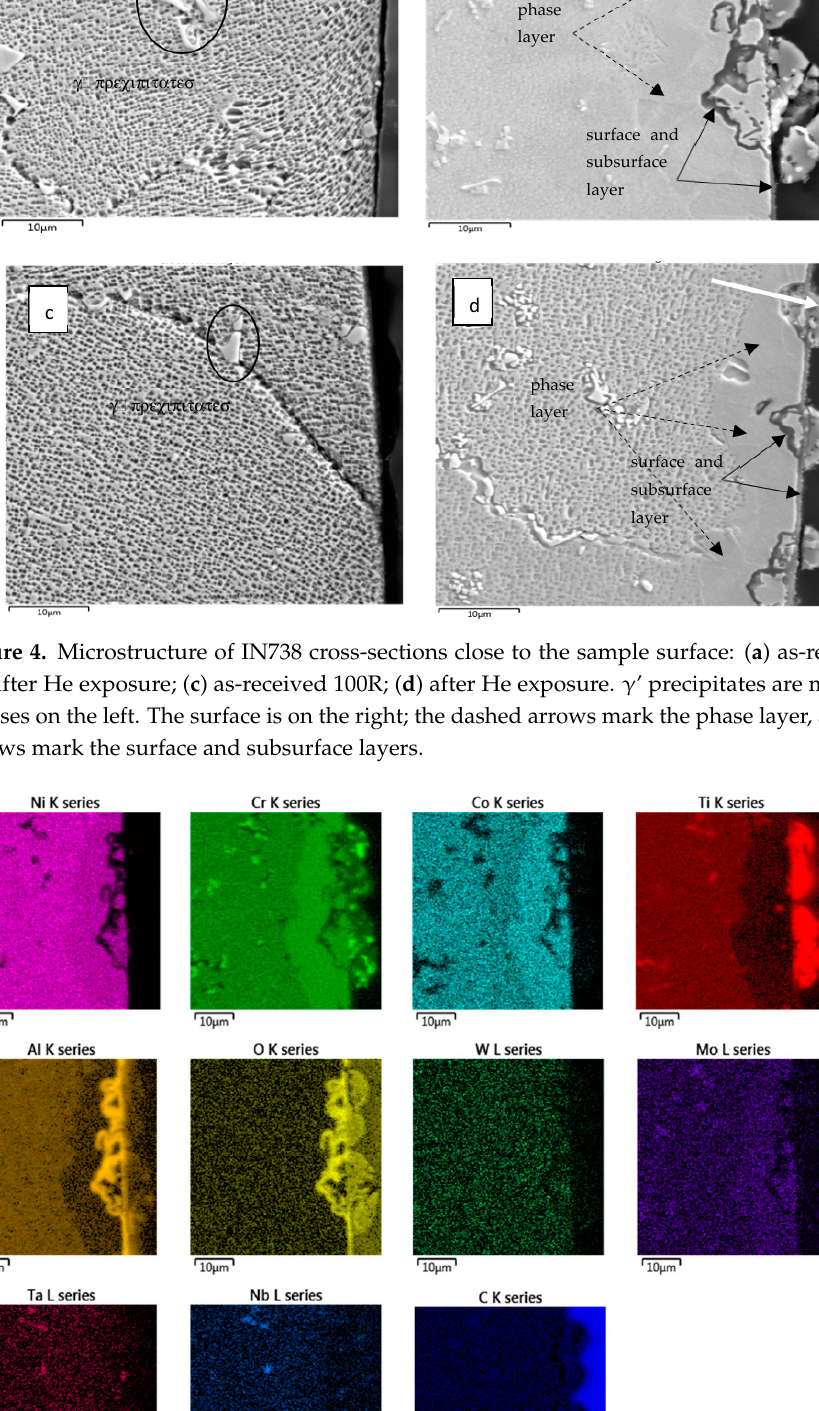
Figure 6. EDX chemical mapping of IN738—100R after exposure to He.